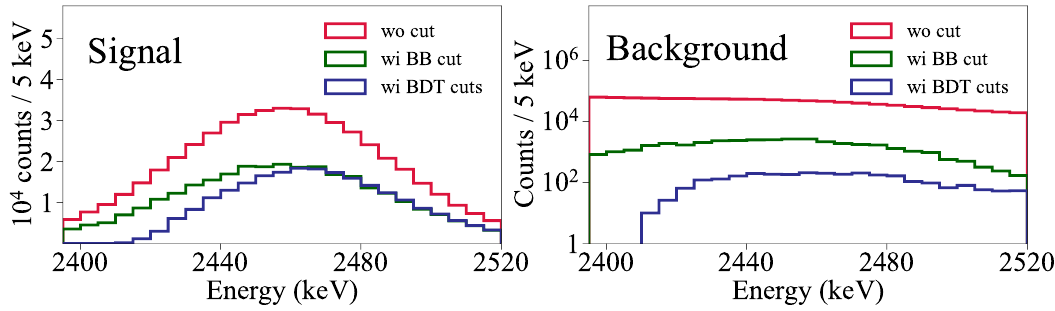
Figure 8. Effects of BB cut and BDT cuts for the signal (left) and background (right). The background count after BDT cuts obviously goes down by about an order of magnitude, compared with that after BB cut. In the BDT cuts, Events with energy less than 2410 keV are rejected because of the E p